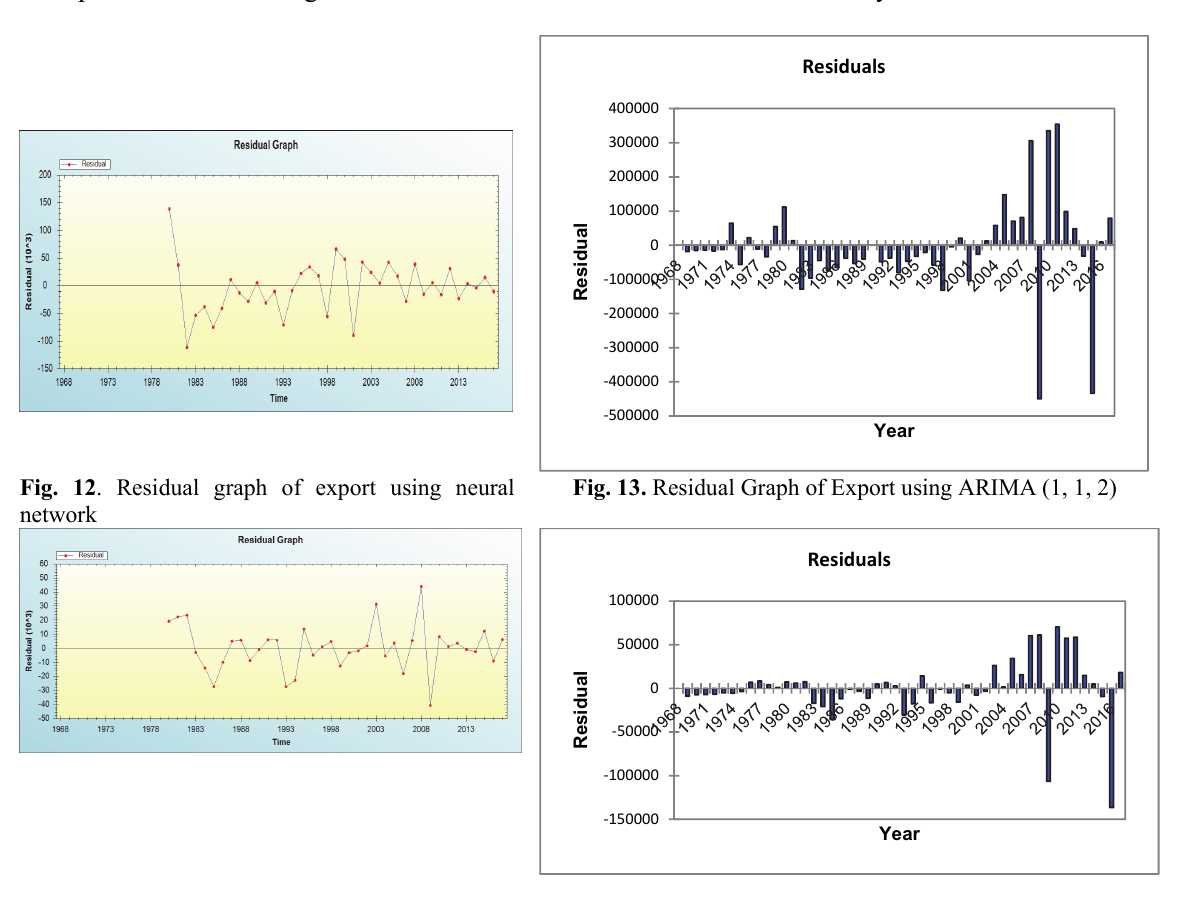
Fig. 14. Residual Graph of Import using Neural Network